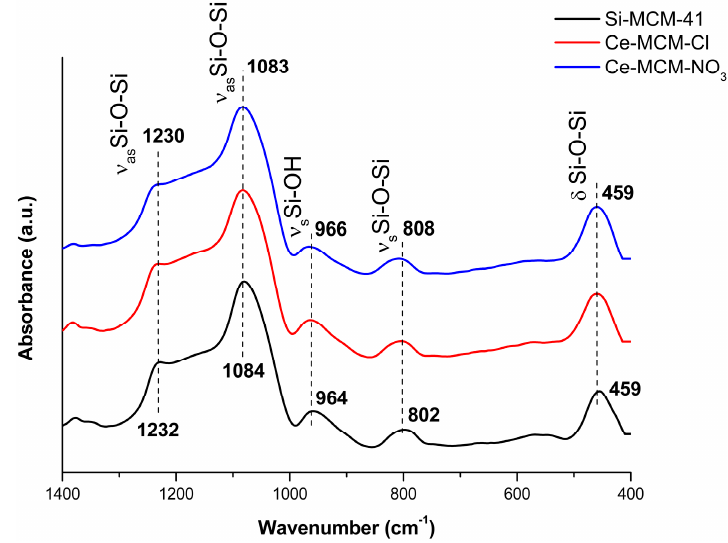
Figure 5. FTIR spectra of the calcined MCM-41 materials.